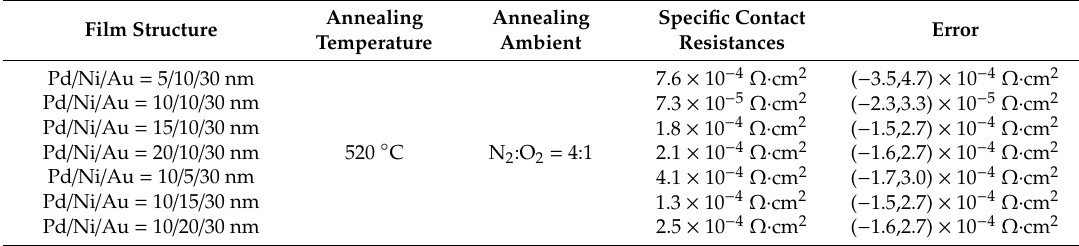
Table 4. The specific contact resistances of Pd/Ni/Au films with different thickness of Pd and Ni. Film Structure